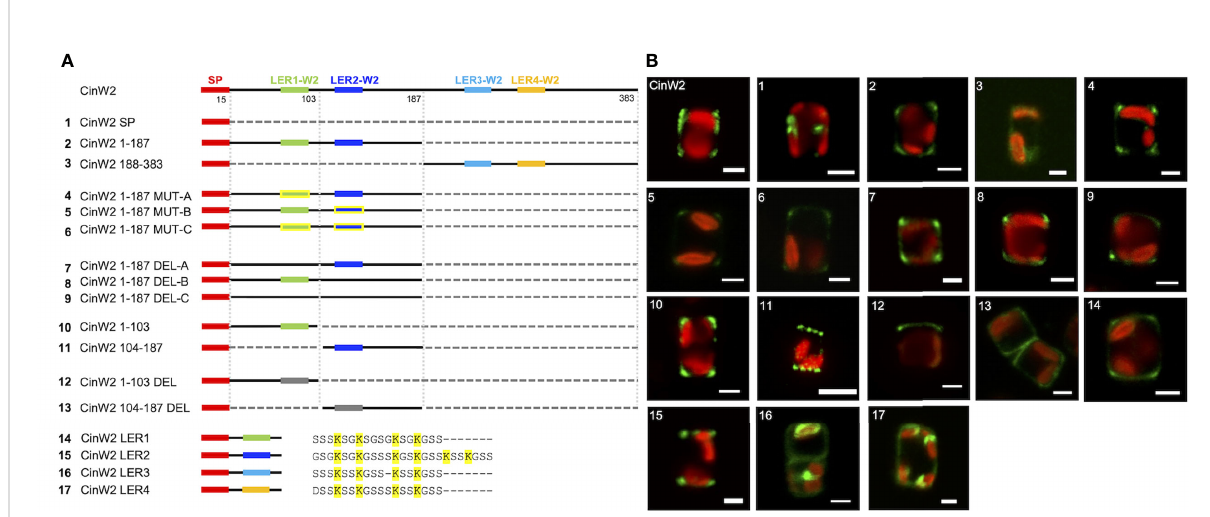
FIGURE 3 Localization experiments using eGFP-fusion constructs derived from CinW2. (A) shows a graphical depiction of the constructs used for the experiments. The color code is: red for the signal peptide (SP), green for LER1-W2, dark blue for LER2-W2, light blue for LER3-W2, orange for LER4-W2, black for the protein backbone, grey for the parts of the protein that have been deleted; the LERs that have been mutated have yellow contour. Next to the four constructs bearing the individual LERs is shown also the amino acid sequence following the SP. (B) shows girdle band view images (merged eGFP and PAF channels) of live cells selected from in vivo localization performed using the constructs shown in the left panel. Scale bars: 2